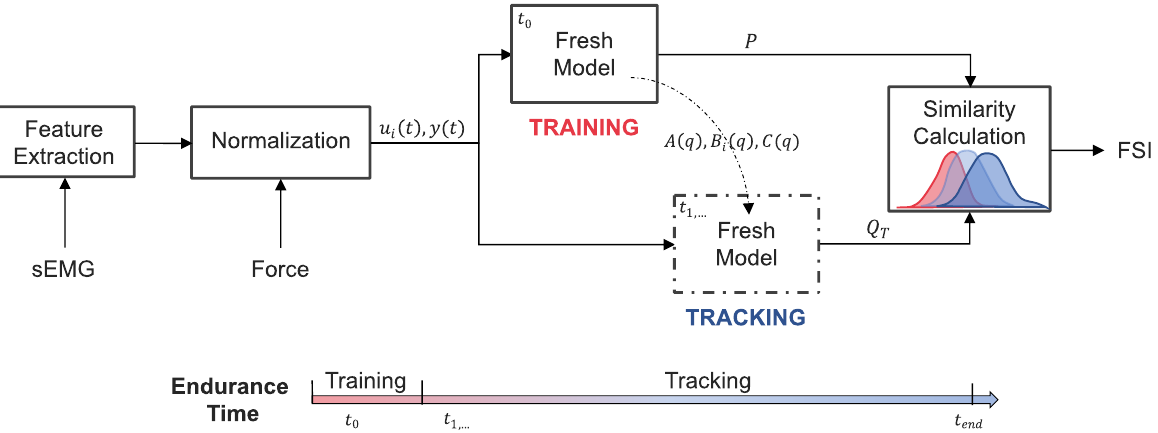
Figure 2. System-based monitoring workflow. Features are extracted from the surface electromyography (sEMG) signals of each muscle. The sEMG features and elbow extension force are then normalized and used as the inputs ( u i ( t ) ) and output ( y ( t ) ) to a dynamic time-series model. Training data from the start of the endurance task ( t 0 ) is used to identify the polynomial coefficients ( A ( q ) , B i ( q ) , C ( q ) ) of the “Fresh Model” and calculate a reference distribution ( P ) of one-step ahead prediction errors. The remaining endurance task data ( t 1,..., end ) is incrementally introduced to the tuned “Fresh Model” for which updated prediction error distributions ( Q T ) are calculated at each time step, T . The overlap between P and Q T is evaluated to obtain a time-series of freshness similarity index (FSI) values that quantify performance